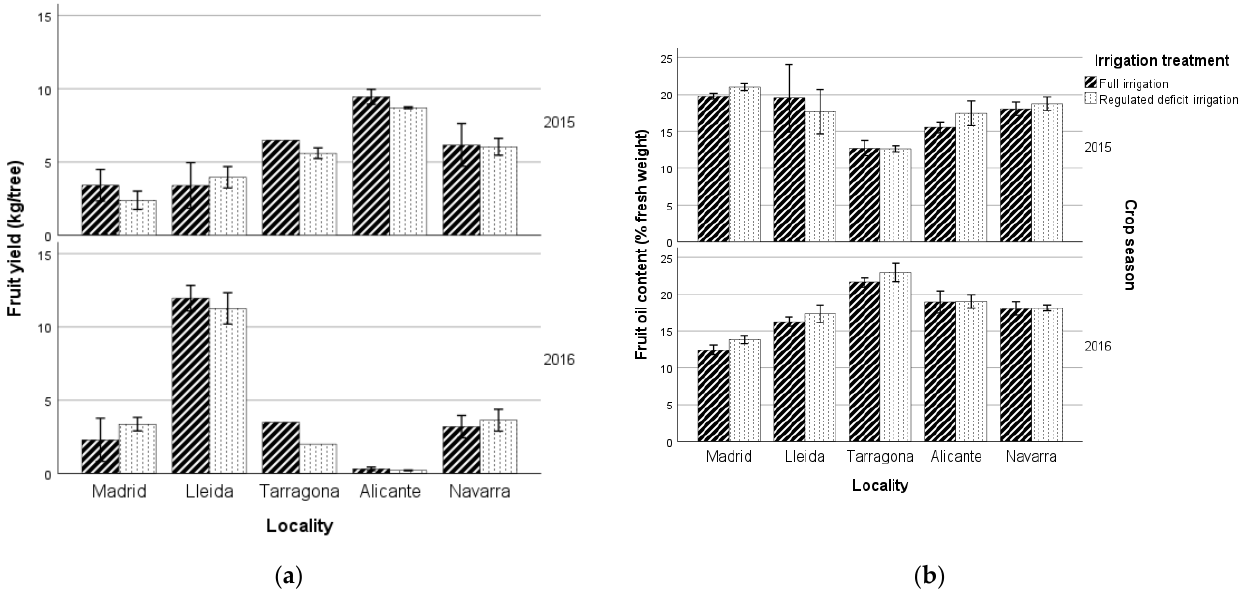
Figure 3. Fruit yield ( a ) and fruit oil content ( b ) under irrigation treatments (FI: full irrigation; RDI: regulated deficit irrigation) in both years and plot location (n = 4). Vertical error bars represent the standard deviation.